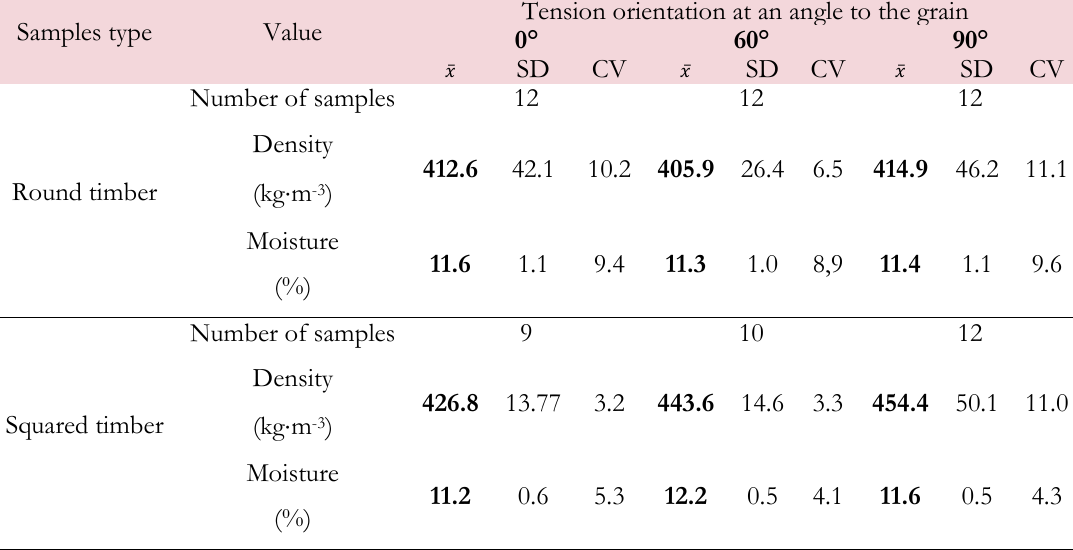
Table 1: Characteristics of tested wood ( x is the arithmetical average; SD is the standard deviation; CV is the coefficient of variation).